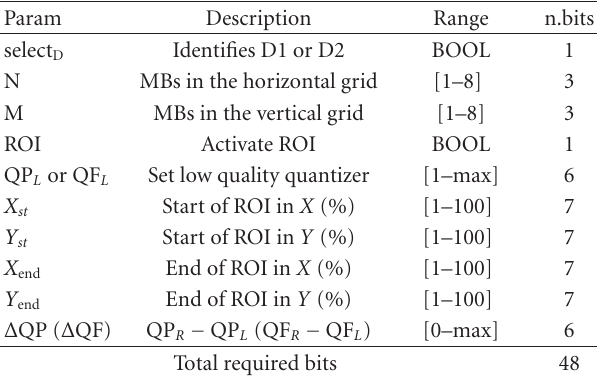
Table 1: Set of parameters for ROI